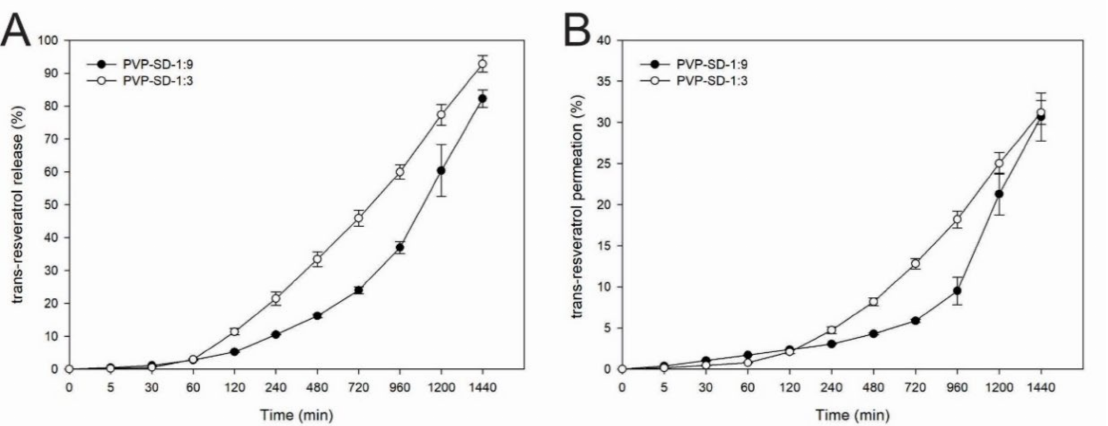
Figure 4. In vitro release ( A ) and in vitro cutaneous permeation ( B ) profiles of trans -resveratrol from the membranes. The profiles are presented as mean ± SD; n = 6.